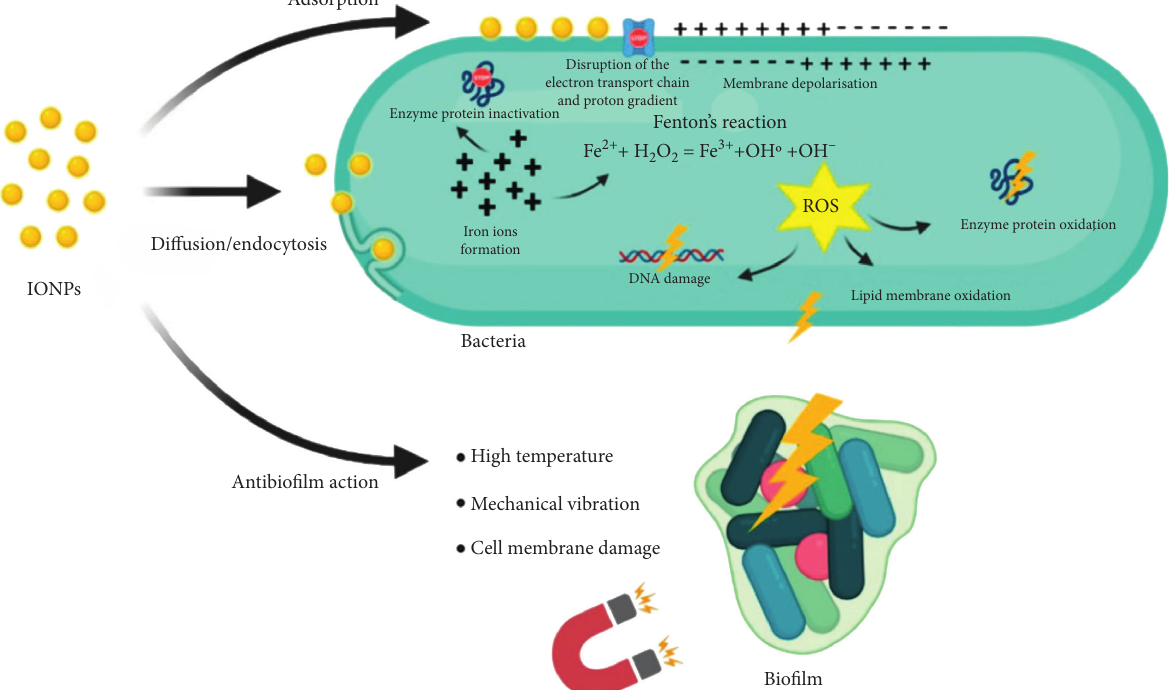
Figure 7: Antibacterial and antibiofilm mechanisms of iron oxide nanoparticles